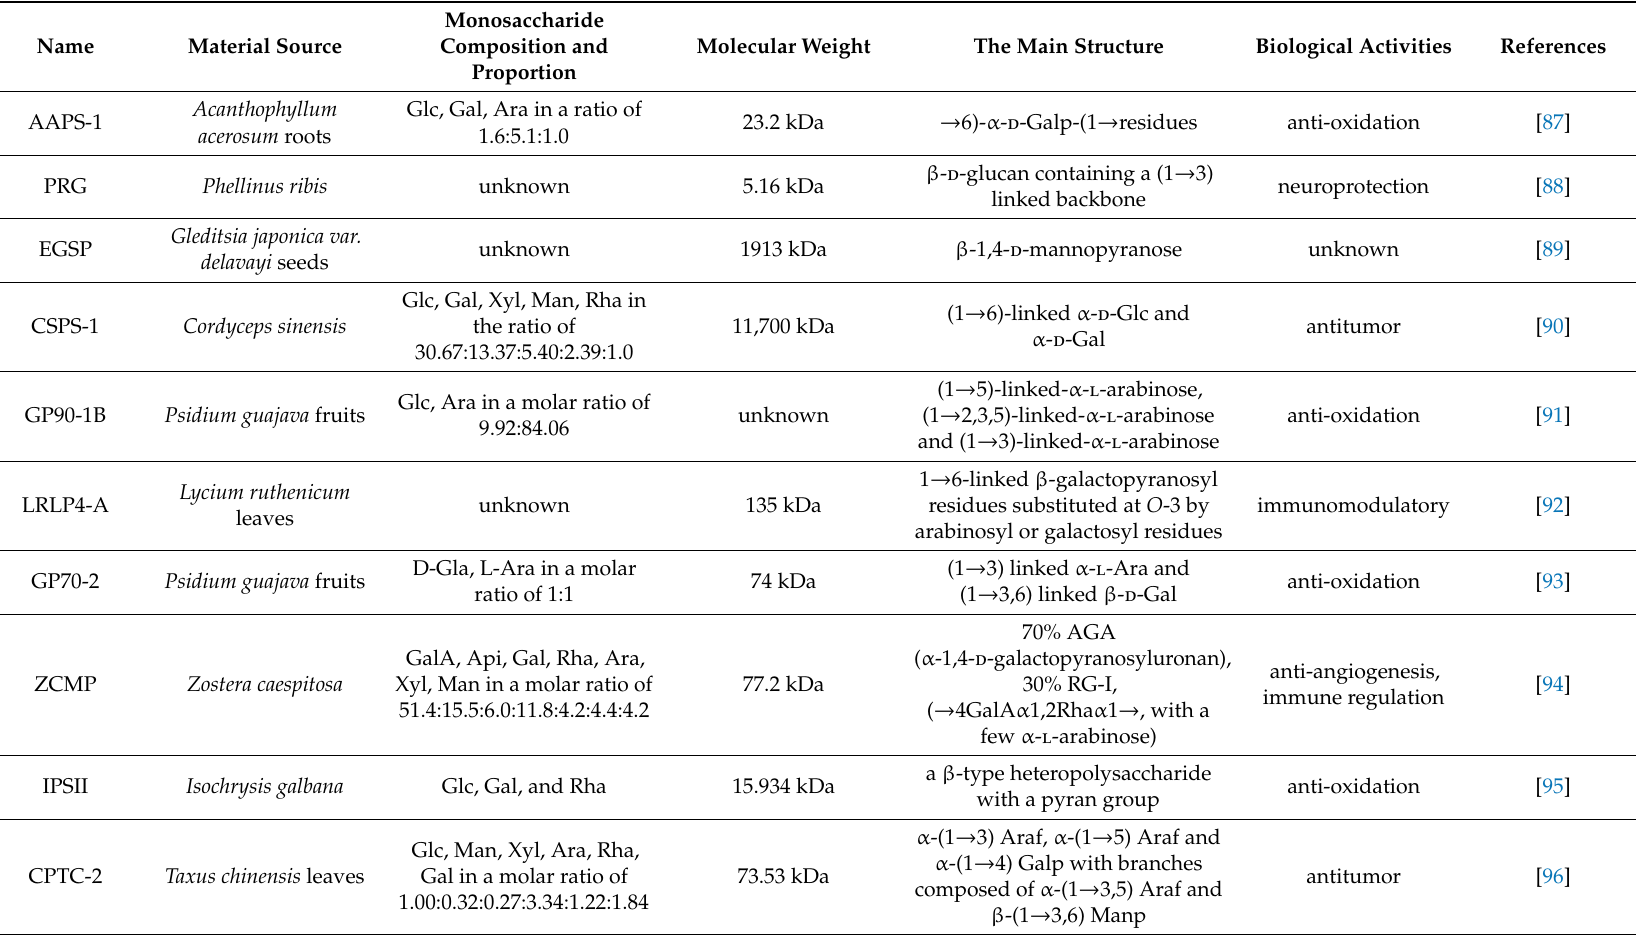
Table 3. Summary of monosaccharides composition, molecular weight, main structure, biological activity, and reference list of natural polysaccharide in recent five